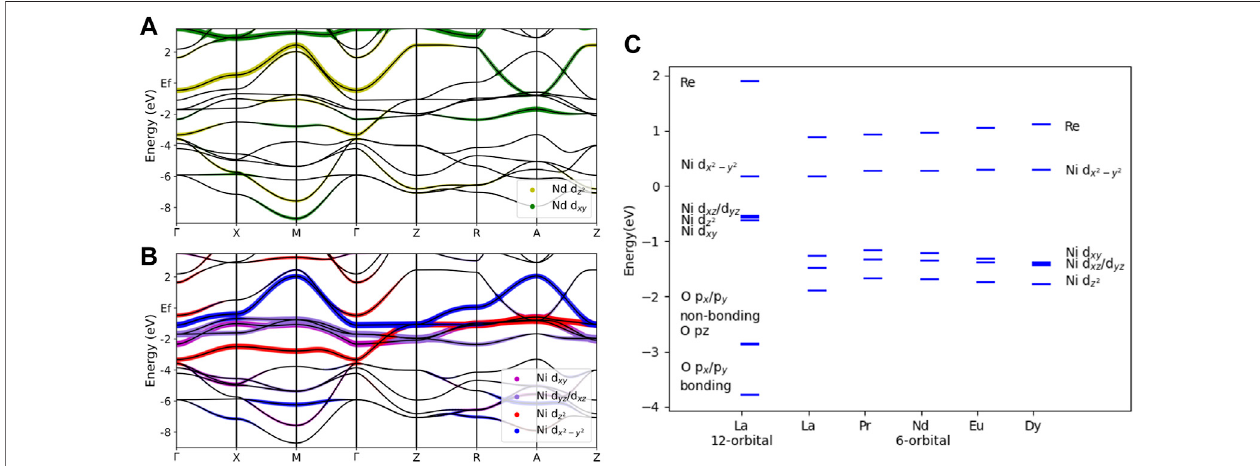
FIGURE1 |(A) DFTcalculatedbandstructureandprojectedNd5 d orbitalcontentforin fi nite-layernickelateNdNiO 2 . (B) DFTcalculatedbandstructureandprojected Ni 3 d orbital content for NdNiO 2 . (C) Atomic energy level diagram for in fi nite-layer nickelates R NiO 2 , where R = La, Pr, Nd, Eu, and Dy. On-site energies are obtained by 6- orbital and 12-orbital Wannier downfolding from DFT calculated band structures. All energy levels are relative to the Fermi level of the corresponding